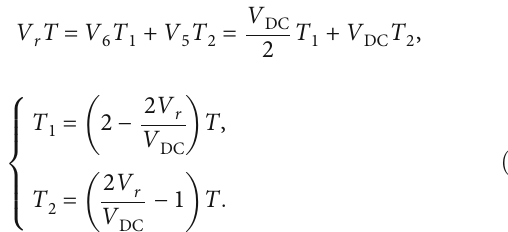
Section A: in this section, amplitude of the inverter refer- ence, V r , is located between 0.5 V respectively. The switching time, T , is divided between these two e ff ective vectors according to Equation (2).